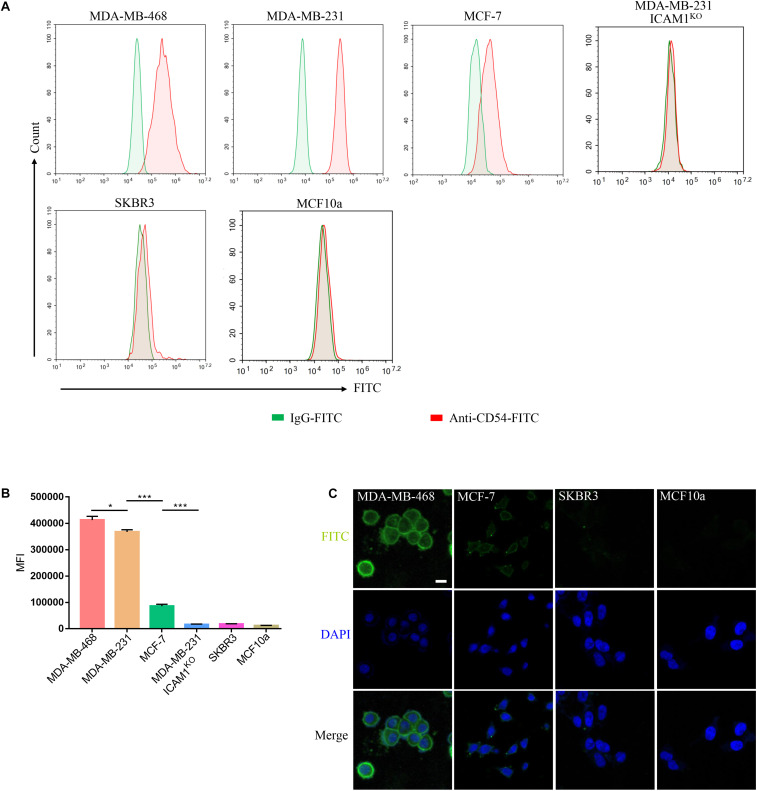
Binding of mG2-scFv to endogenous ICAM1 in breast cancer/normal cell lines. (A) Expression of ICAM1 in human breast cancer cells and normal breast cell were evaluated by FACS. Cells were incubated with anti-ICAM1-FITC (red) or IgG-FITC control (green). (B) Quantification of ICAM1 staining intensities in various breast cancer cells and normal breast cells. Unpaired two-tailed Student’s t-tests were applied. *p < 0.05, ***p < 0.001. (C) IF staining with mG2-scFv-Fc in target cells. Scale bars, 50 μm.